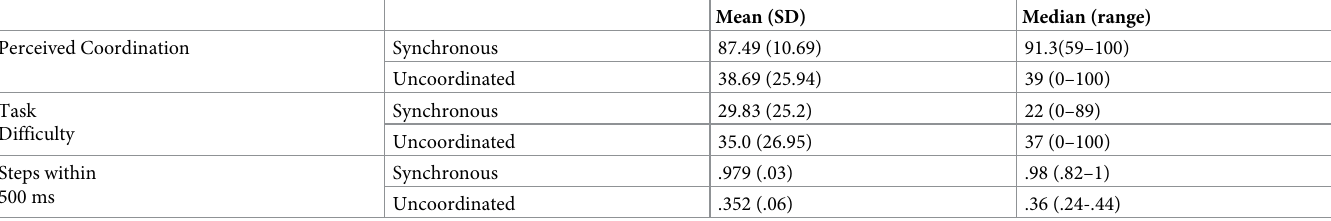
Table 1. Descriptive statistics for manipulation check questions.